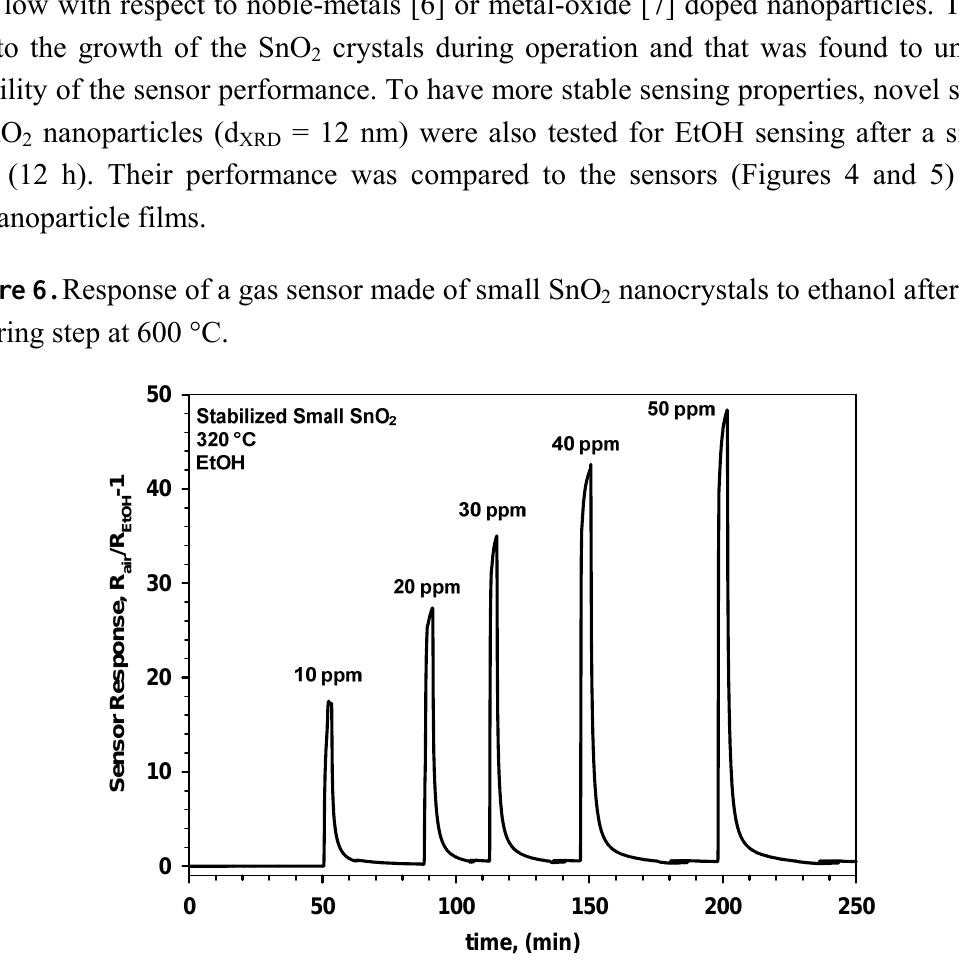
nanocrystals to ethanol after a 12 h 2